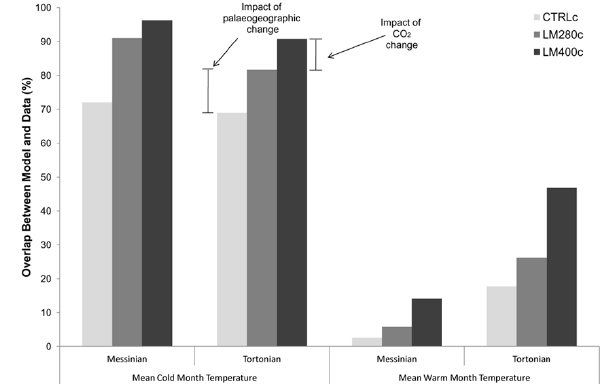
Fig. 18. Model–data comparison summary for CMT and WMT. Shown is the percentage of the total number of datapoints that over- lap with the model